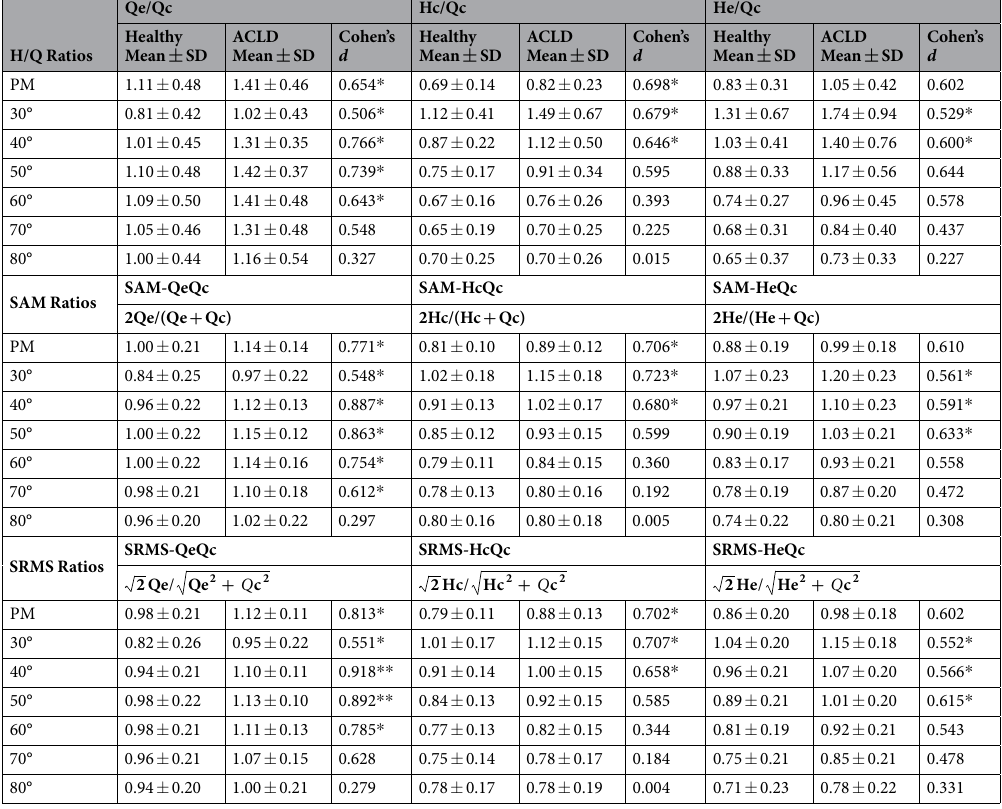
Table 3. H/Q ratios, SAM and SRMS form indices of peak moments and angle-specified moments ( N = 46). Single upper asterisk * denotes significant differences at P < 0.05, and double upper asterisk ** denotes significant differences at P < 0.01. SD, standard deviation; ACLD, anterior cruciate ligament deficient side; PM, the peak moment; Cohen’s d , effect size between the ACLD limb and the healthy limb. H/Q, hamstring to quadriceps ratios; SAM, single-to-arithmetic-mean form indices; SRMS, single-to-root-mean-square form indices; Qe, quadriceps eccentric contraction; Qc, quadriceps concentric contraction; He, hamstring eccentric contraction; Hc, hamstring concentric